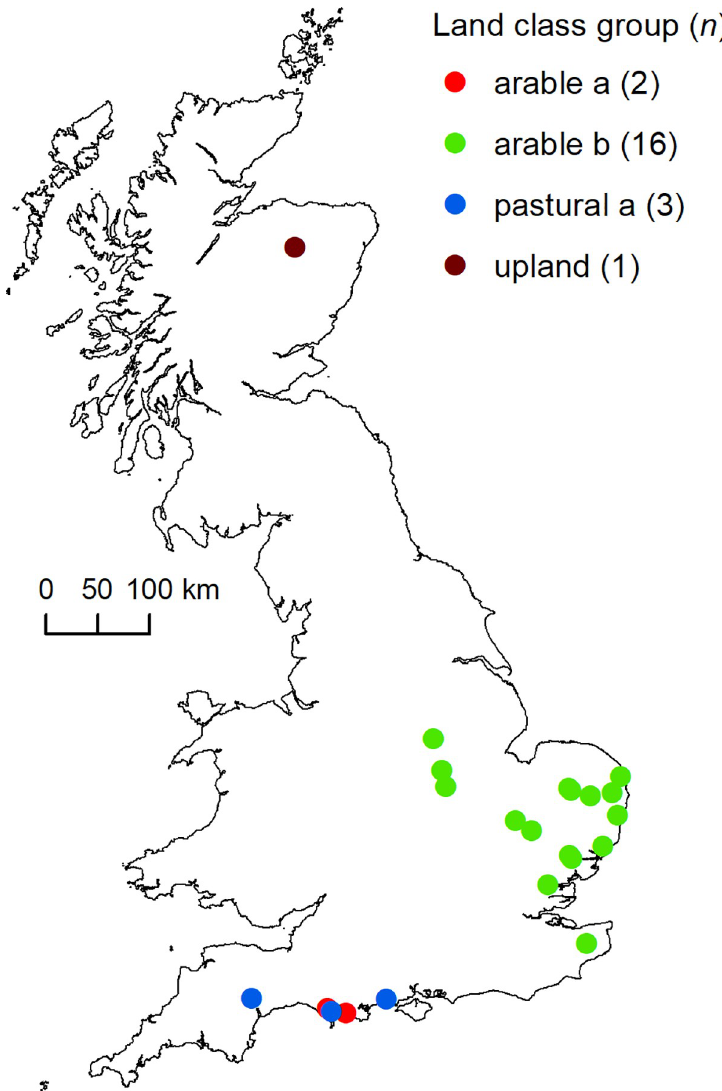
Fig 1. Locations of the 22 modelled estates showing the landscape type each estate was within. Landscape types were determined by groupings of land class strata which summarise variation in ecological, physio-geographical, and human geographical attributes (see [30] for